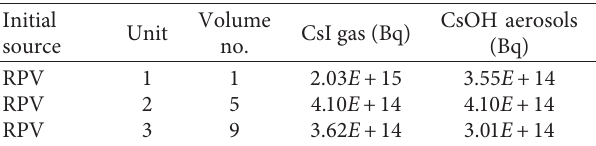
Table 2: Cesium source term in the RPVs for the calculation in Modified ART Mod